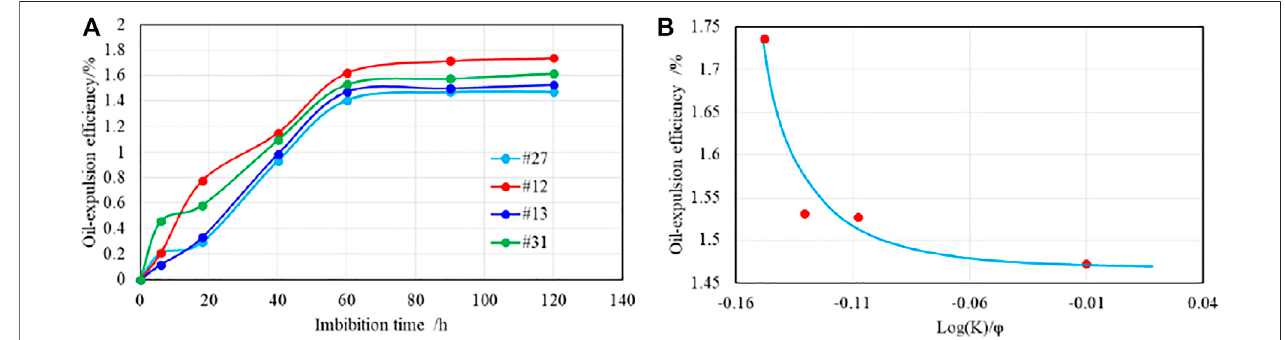
FIGURE 2 | Variation characteristics of imbibition oil-expulsion ef fi ciency. (A) Relationship between oil-expulsion ef fi ciency and imbibition time; (B) relationship between oil-expulsion ef fi ciency and reservoir physical property.